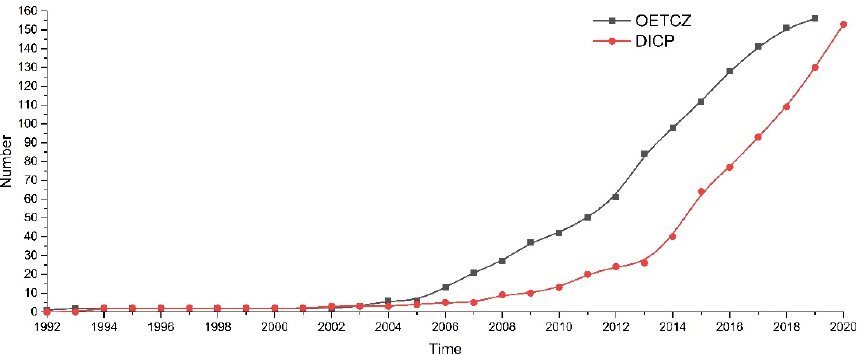
Figure 2. The number of OETCZs and DICPs since 1990. (OETCZ: overseas economic and trade cooperation zone; DICP: domestic international cooperation park).